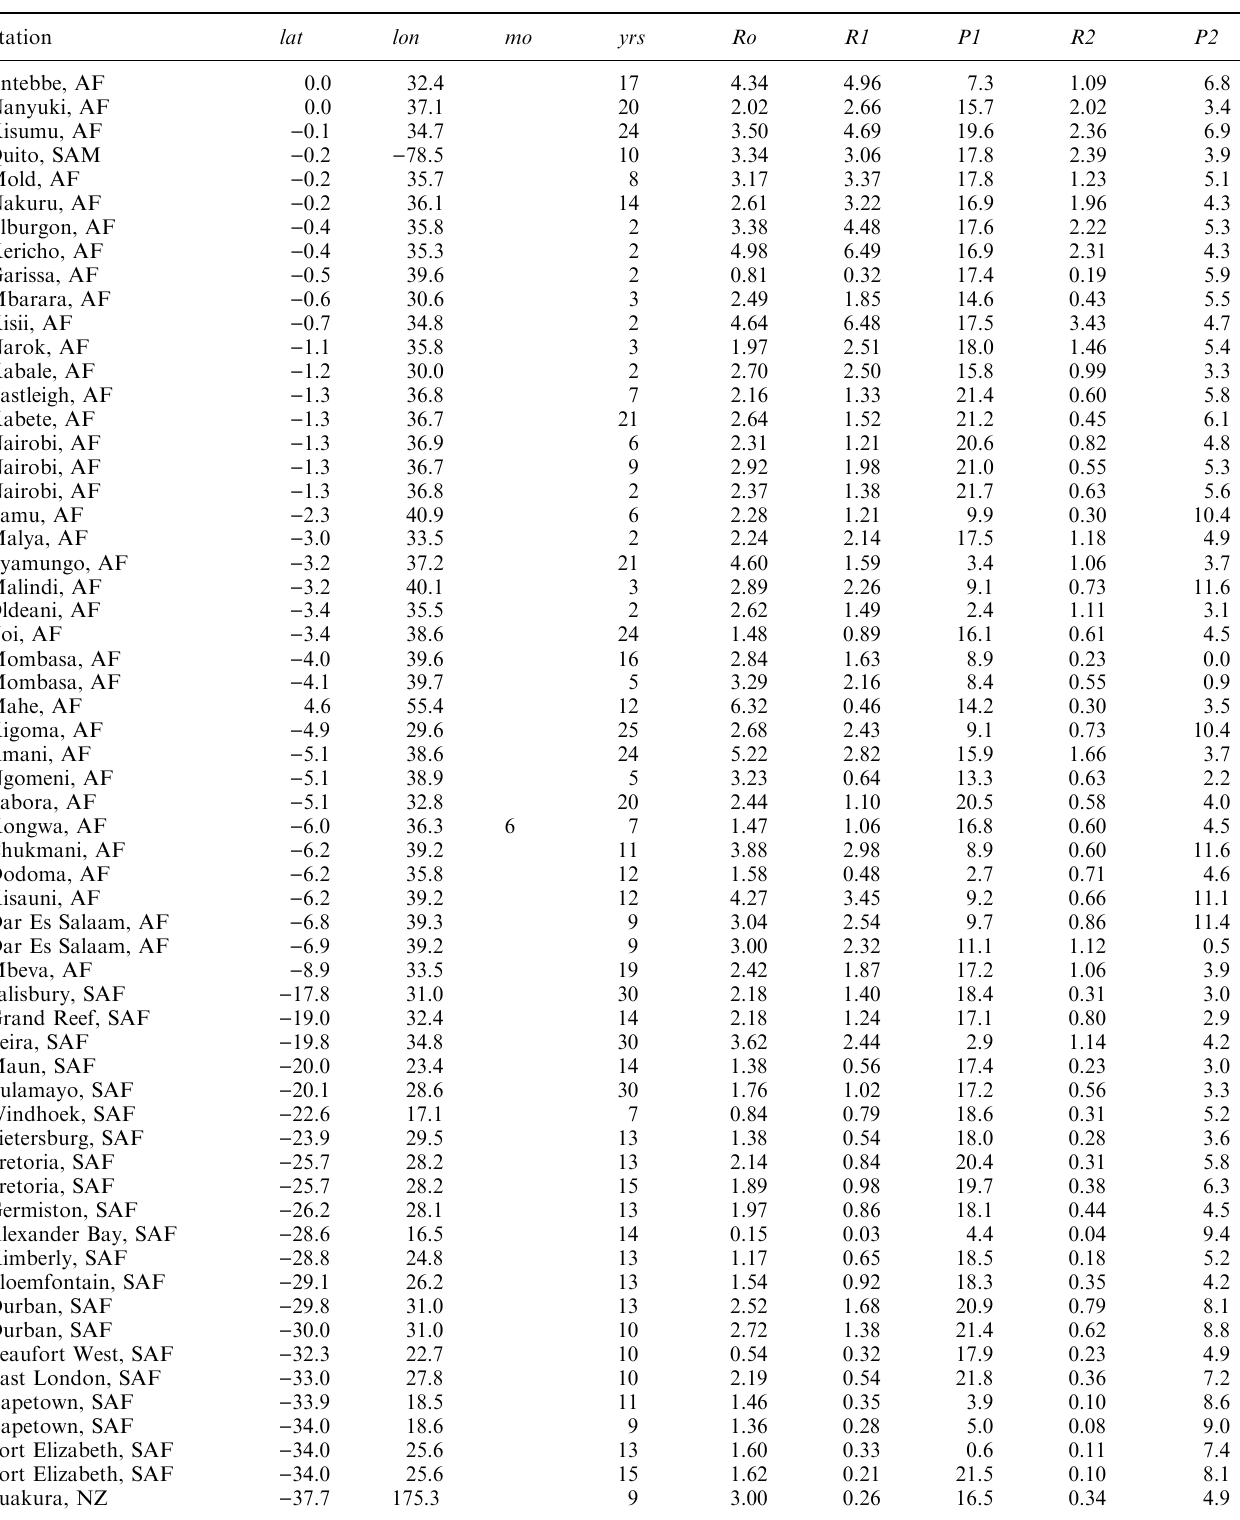
Table 2. ( contd .) Station Entebbe,